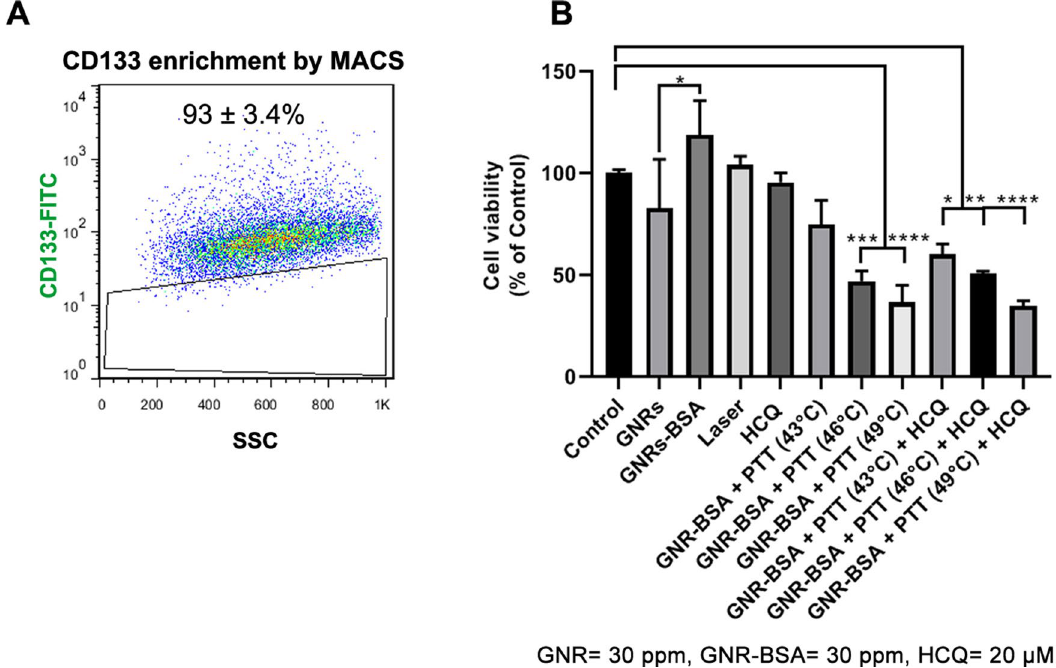
Figure 2. Enrichment of CD133 + CSCs using MACS ( A ). Over 90% of isolated cells were positive for surface marker CD133. Measuring the CSC survival rate using MTT assay ( B ). Data showed the reduction of GNRs toxicity after coating with BSA. The exposure of CSCs to low, medium, and high temperatures caused CSC viability rates compared to the control group. The combined regime of PTT and HCQ did reduce cell survival as compared to the non-treated CSCs. One-Way ANOVA and Tukey post hoc analysis. * p < 0.05; ** p < 0.01; *** p < 0.001 and **** p <